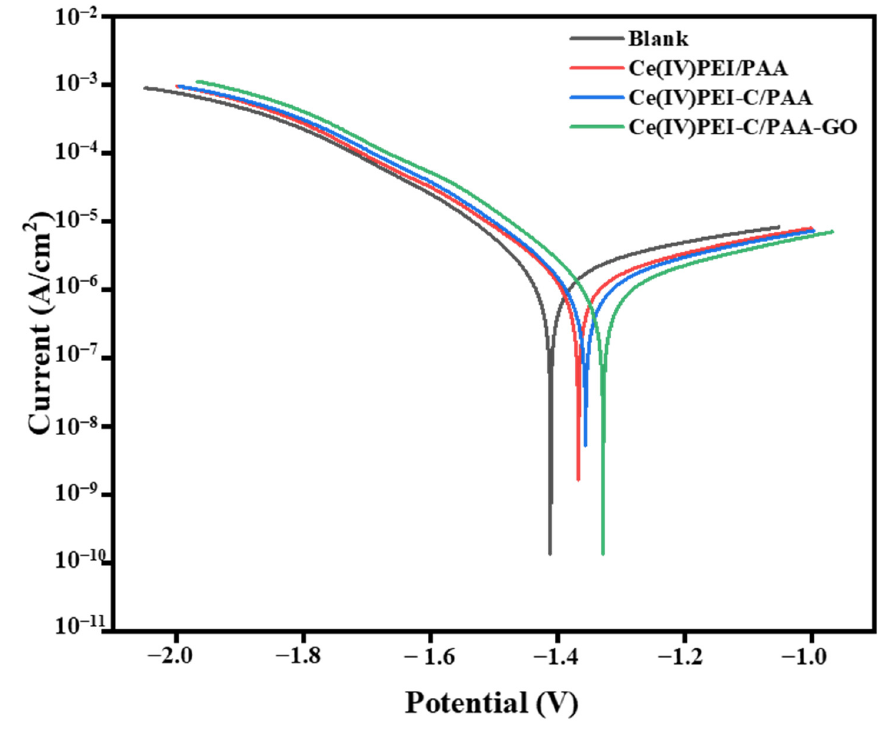
Figure 8. Polarization curves of bare AZ31B alloy and the alloy coated with different sample compositions immersed in a 3.5 wt% NaCl solution for 72 h. Table 2. The sample fitting results of the polarization curves.